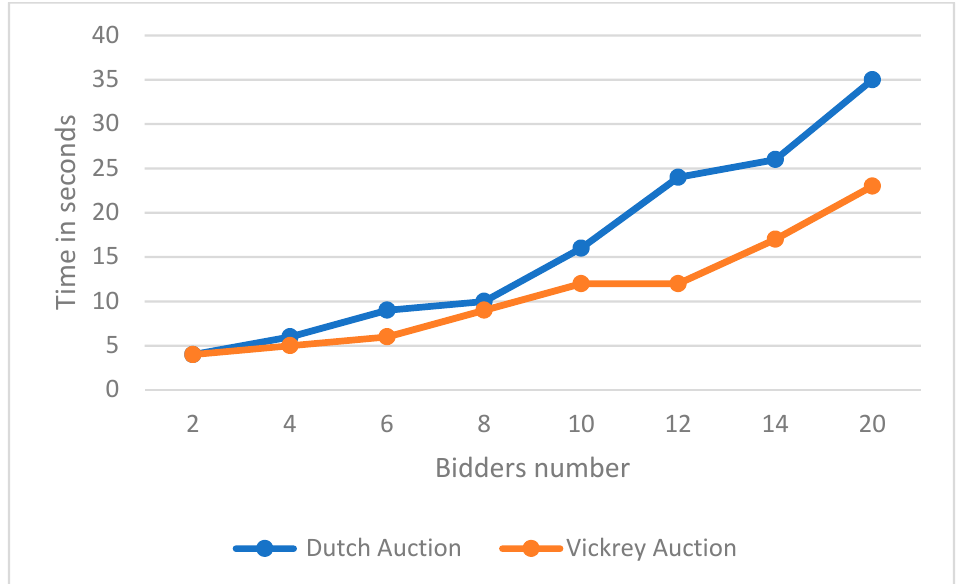
Figure 7. Time required to complete an auction as the number of bidders grows in a demand-driven scenario.